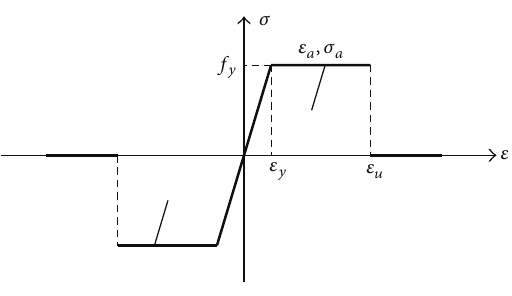
Figure 3: Stress-strain curve of